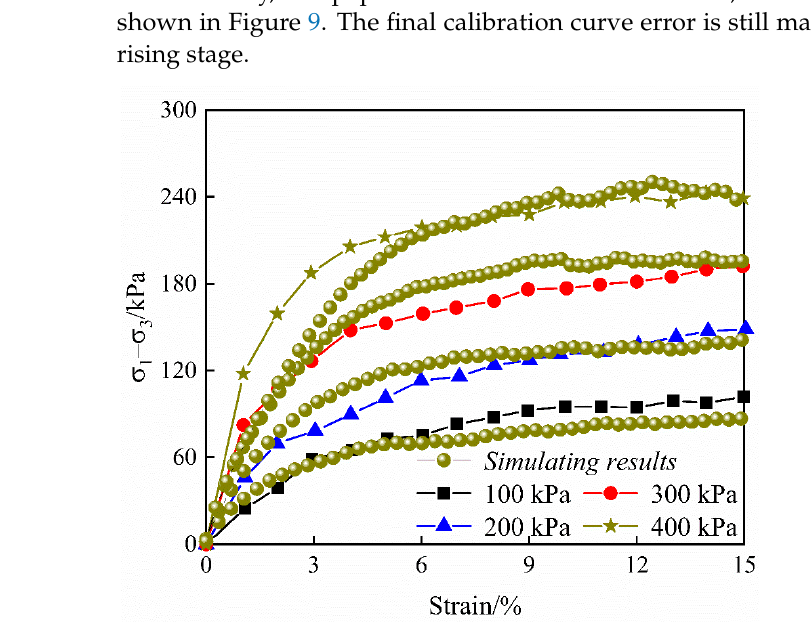
Figure 9. Stress–strain curves of remolded soil in DEM.